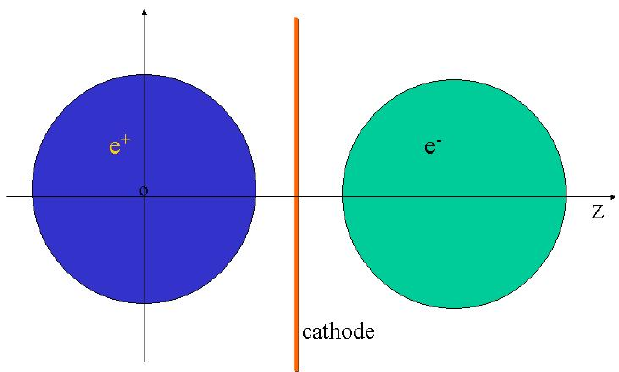
FIG. 2. (Color) Image-charge electric potential on the axis for a round beam from the shifted-Green function solution together with the analytical